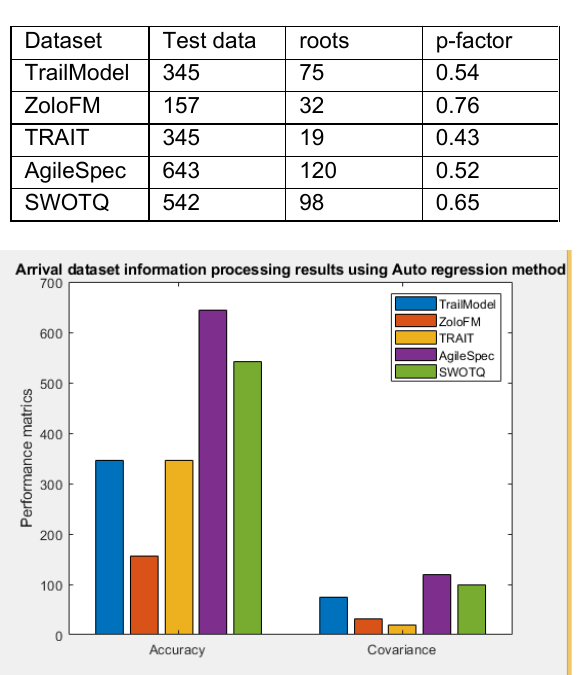
Table 3. p-factor result from Redshit tool